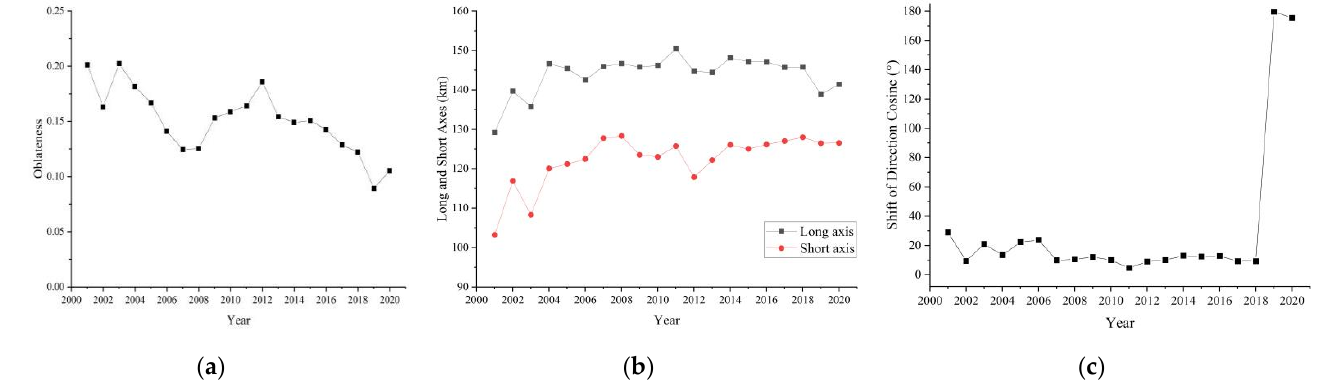
Figure 15. Henan Province 2001–2020 standard deviation ellipse parameters: ( a ) oblateness, ( b ) long and short axes, and ( c ) shift of direction